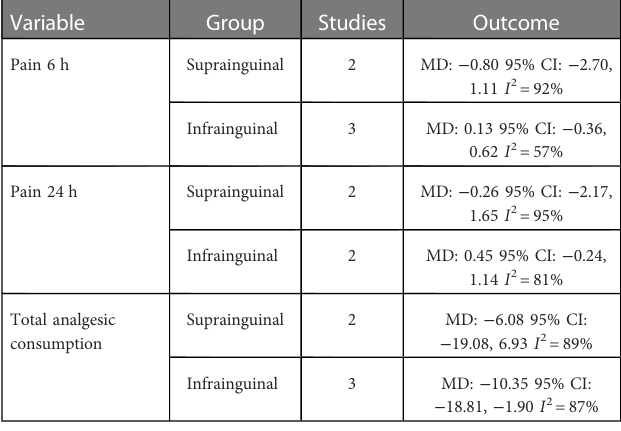
TABLE 2 Subgroup analysis based on type of fascia iliaca compartment block.